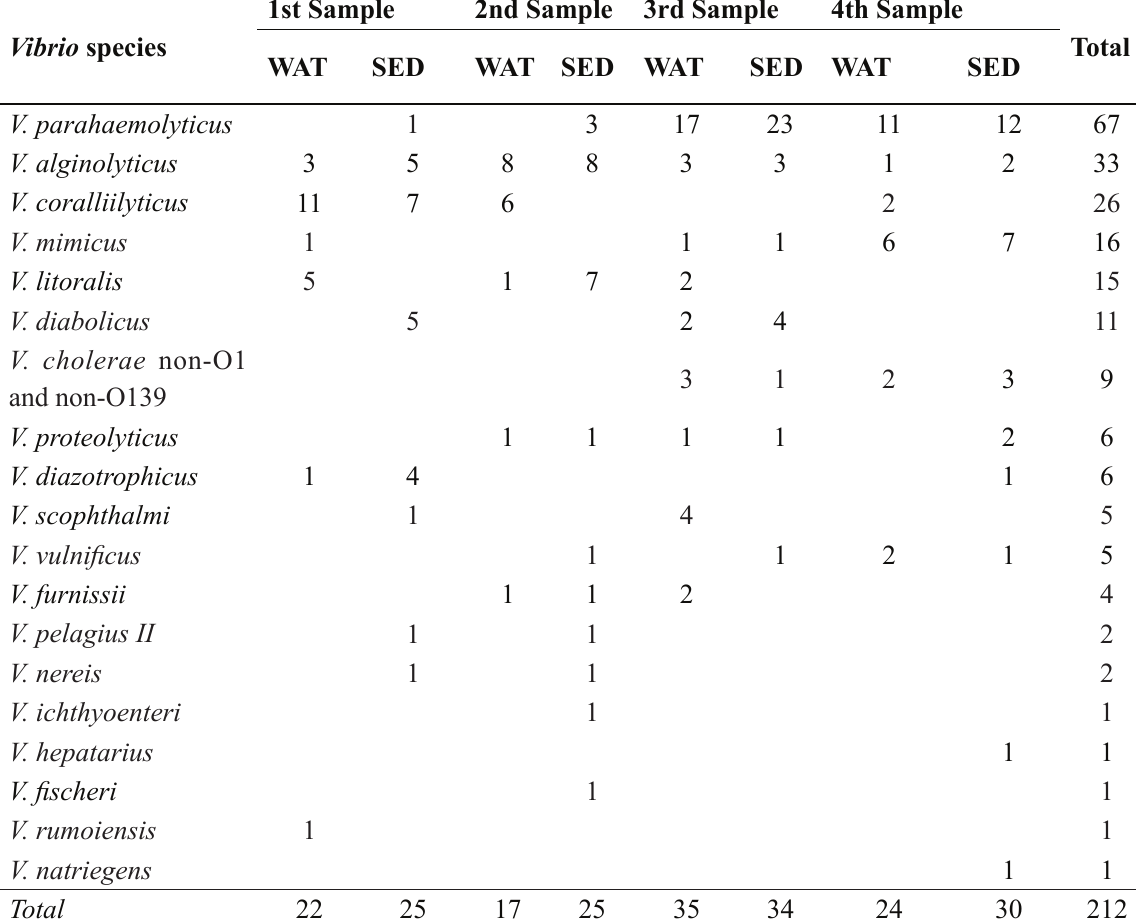
Number of strains of Vibrio species detected in the water and sediment samples collected in the estuaries of rivers Pacoti, Choró, Pirangi and Jaguaribe